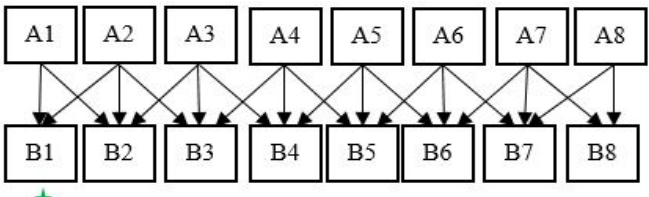
Figure 2. Eight individuals of first-generation (the green sign means the current optimal solution).